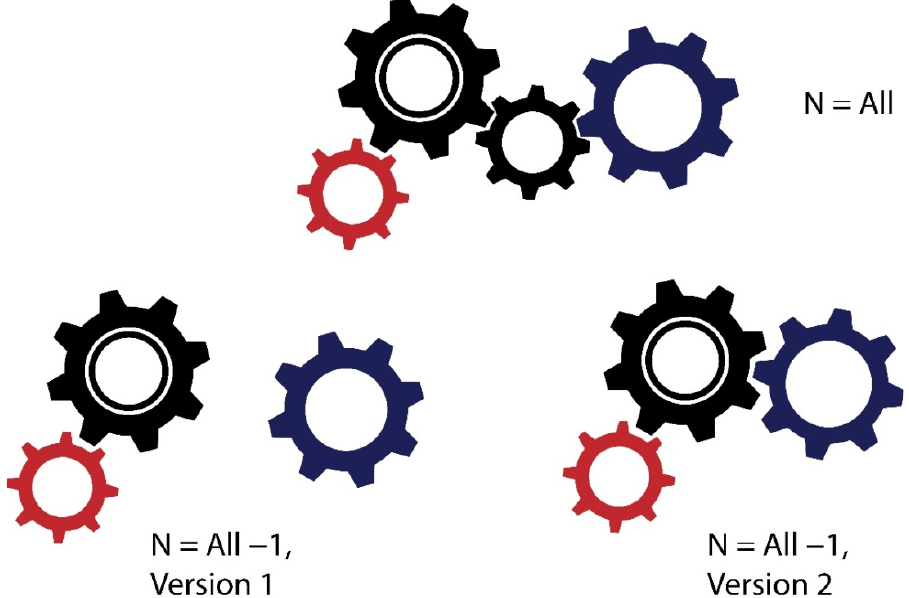
Figure 1. A simple illustration of the data incompleteness problem. Achieving “n = all” for many biological data may be an unreachable or unrealistic goal. With the same set of incomplete data, it is possible to arrive at different versions of the organization of any biological process.